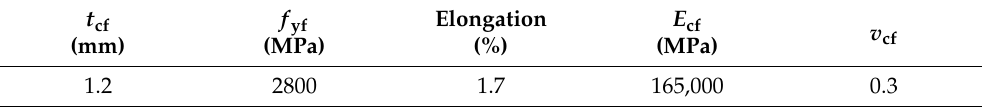
Table 4. Mechanical properties of the CFRPs. Adapted from Ref.